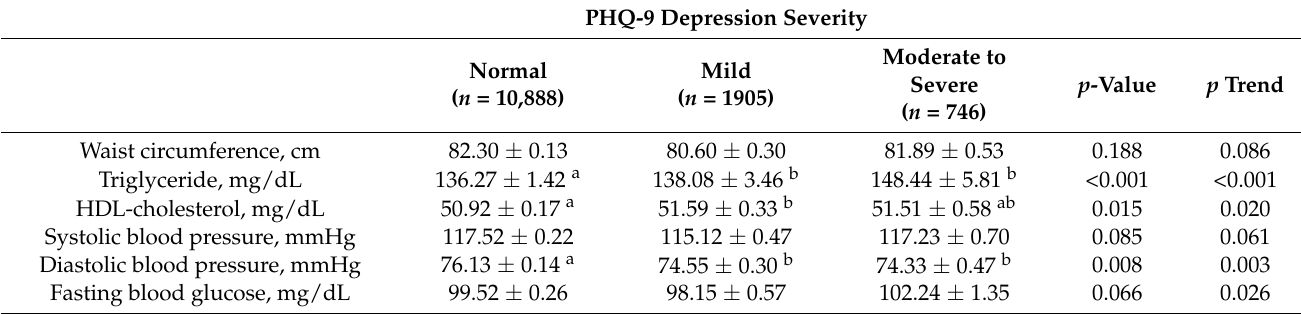
Table 6. Metabolic syndrome biomarkers of subjects according to depression severity.